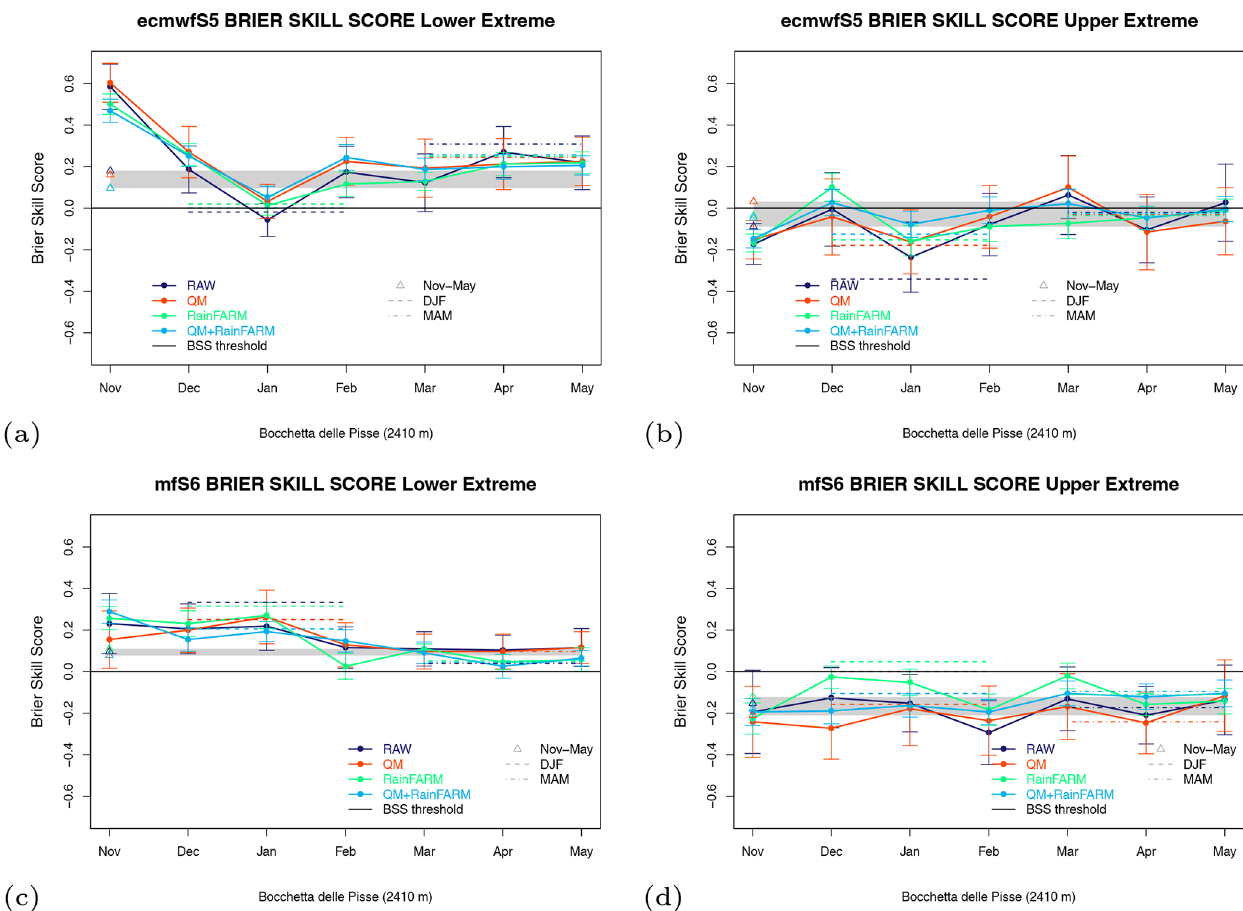
Figure 13. Brier skill score for seasonal forecasts of monthly and seasonally averaged snow depth (a, c) below the 10th percentile (P10) and (b, d) above the 90th percentile (P90) for (a, b) ECMWFS5 and (c, d) MFS6 forcing, starting date 1 November, lead times of 1 to 7 months, for the site of Bocchetta delle Pisse. Coloured dots represent the BSS for each month and each experiment; dashed (dotted-dashed) horizontal lines represent DJF (MAM) BSS values; and the grey-filled rectangle and the four coloured triangles all refer to the seasonal (November– May) snow depth forecasts, and they precisely indicate the BSS spread among different experiments and the BSS values for each of the four experiments,